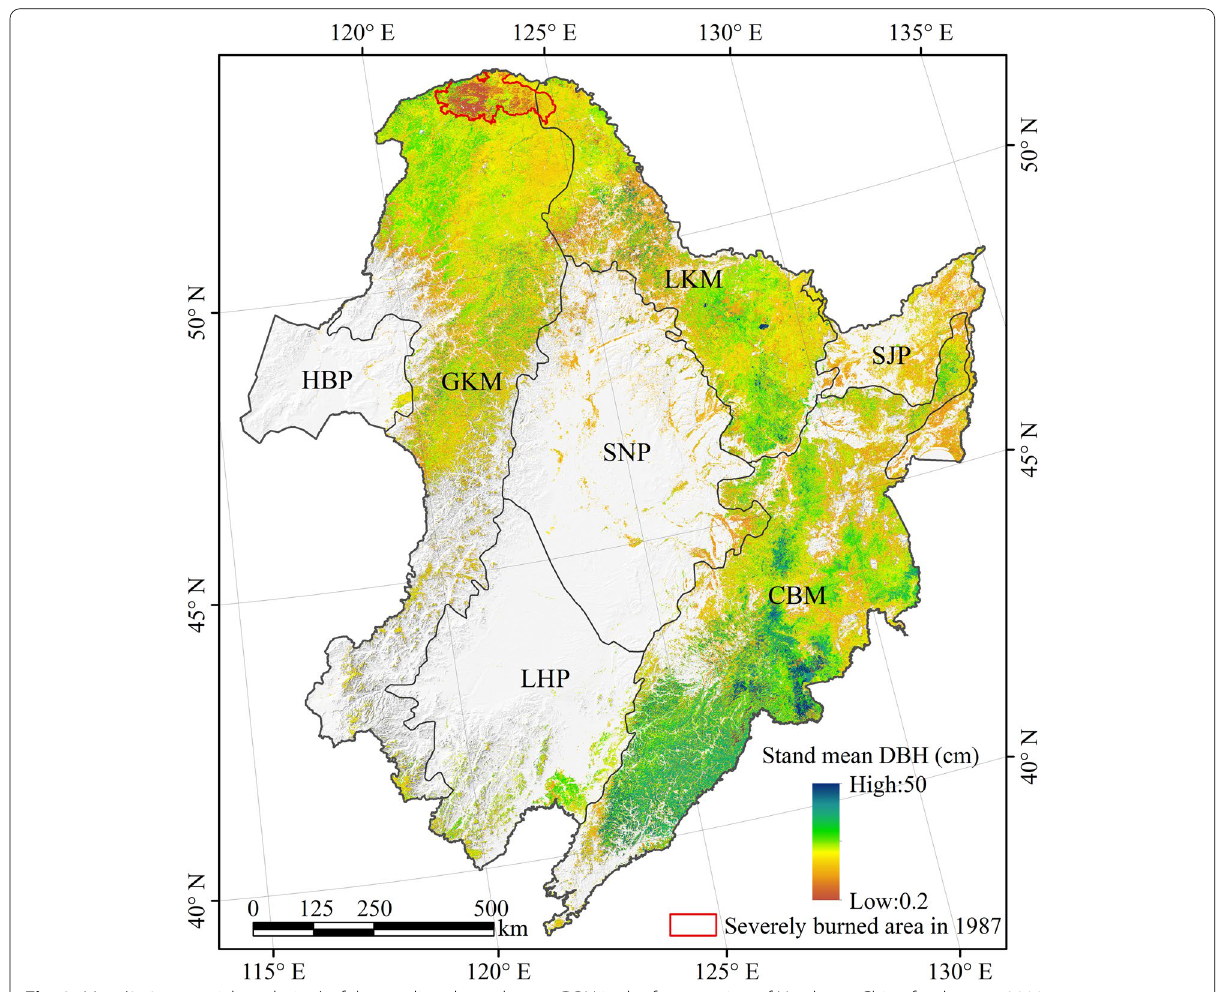
Fig. 3 Map (250-m spatial resolution) of the predicted stand mean DBH in the forest region of Northeast China for the year